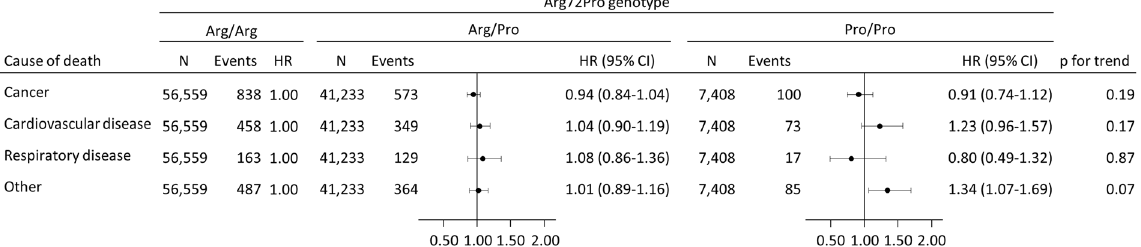
Figure 3. Cause-specific mortality according to TP53 Arg72Pro genotype in individuals in the general population. Hazard ratios were adjusted for age and sex. Follow-up started at the day of baseline examination and ended at death, emigration or November 14, 2014 whichever came first. Death endpoints were collected from the Danish Civil Registration System. Cause of death was collected from the Danish Register of Causes of Death. The sum of all events is lower than the sum of all-cause mortality events in Fig. 1 since the Danish Register of Causes of Death lags slightly behind the registration of all-cause mortality. Also, the sum of events differs from the number of deaths among cancer diagnosed individuals which are shown in Fig. 1. p-values for trend were calculated using Cox regression with Arg72Pro genotype as a continuous variable. CI; Confidence interval. HR; Hazard ratio.